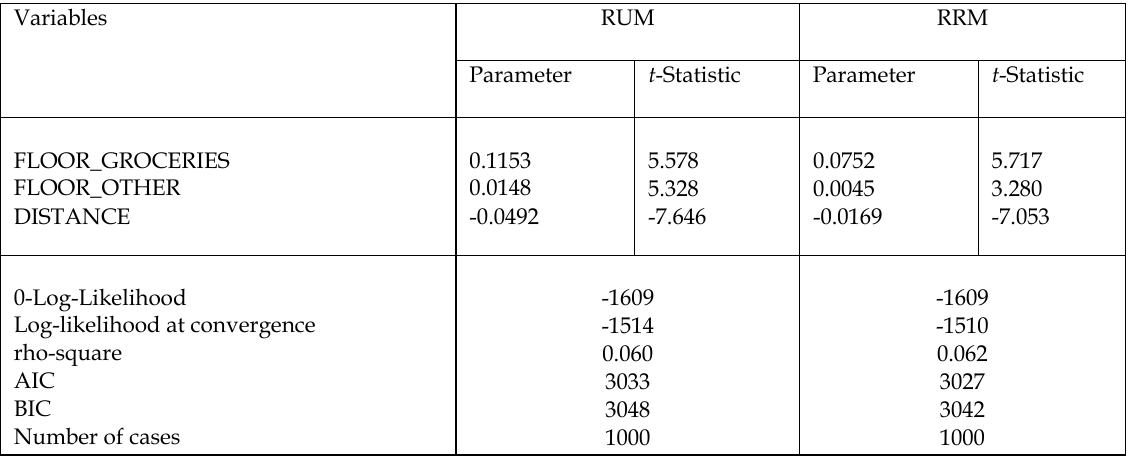
Table 4. Shopping location choices (estimation results)